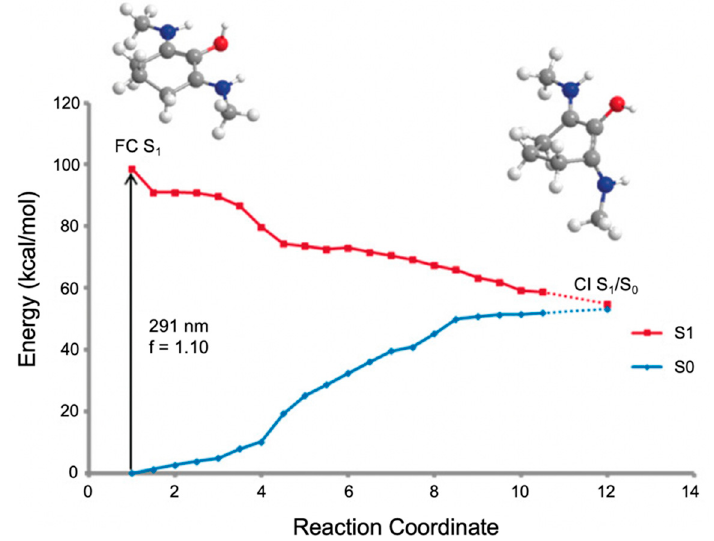
Figure 15. Computed MEP of molecule 6 by Losantos et al. [89], where f is the oscillator strength. Reproduced and adapted with permission from [89]. © 2017 Wiley-VCH Verlag GmbH & Co. KGaA, Weinheim.